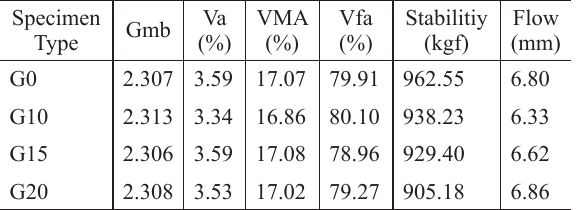
Table 5. The average values of the characteristics of the mixtures Specimen